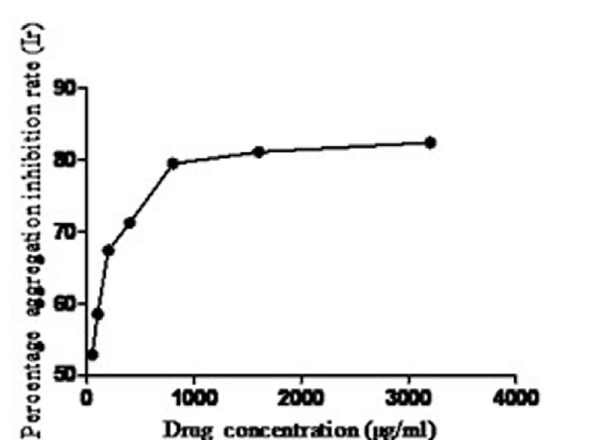
FIGURE 3 - Effect of EECR on CaOx crystal